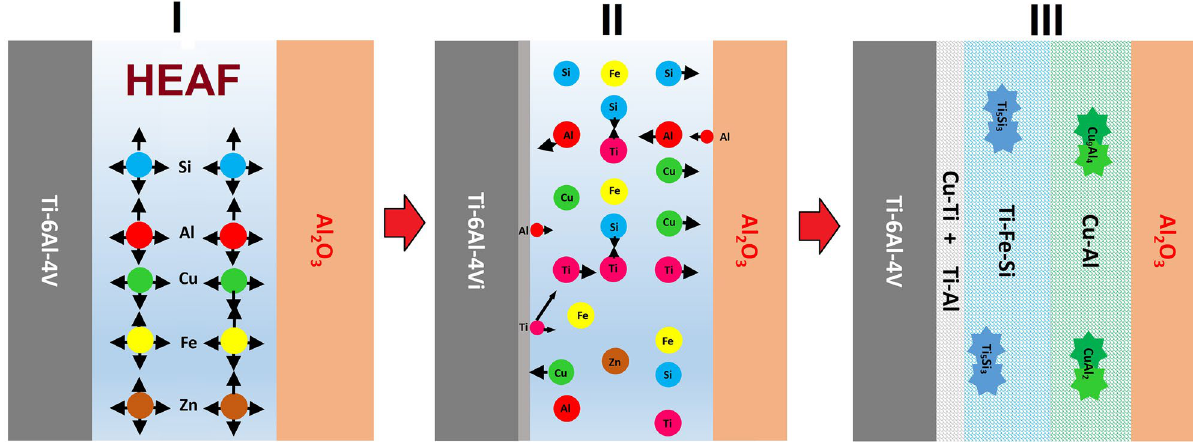
Figure 8. Microstructural model for the Al 2 O 3 /Ti–6Al–4V joints at various